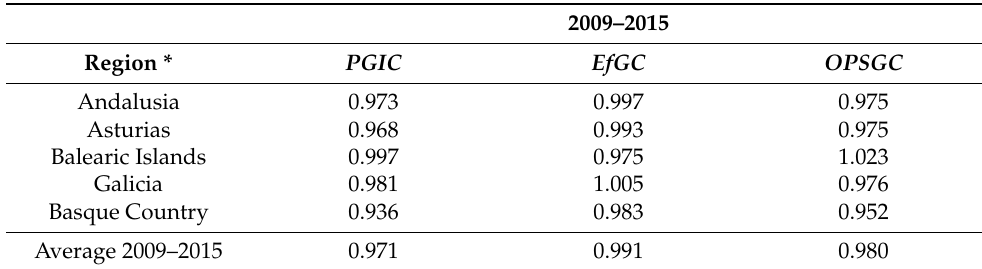
Table 5. PGIC and its decomposition into effectiveness gap change and outcome possibility gap change over the period